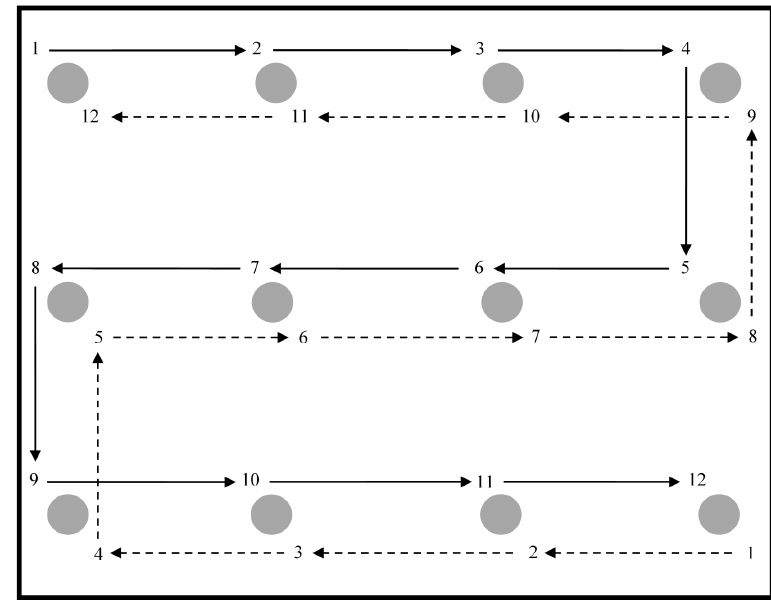
Figure 4. Experimental stimulus: circle movement sequences. The bold frame represents computer screen. The gray circles represent the twelve possible positions of either blue or red circle. Solid arrows represent blue circle’s movement sequence. Dotted arrows represent red circle’s movement sequence. Each ordered number sequence (from 1 to 12) depicts the direction of blue circle’s course and the red circle’s course,